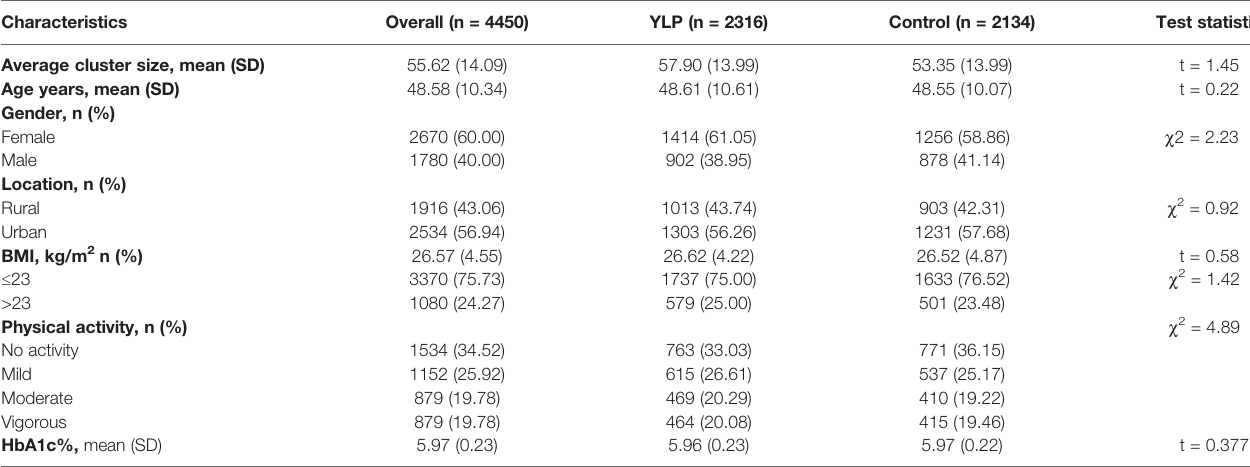
TABLE 1 | Baseline data for trial